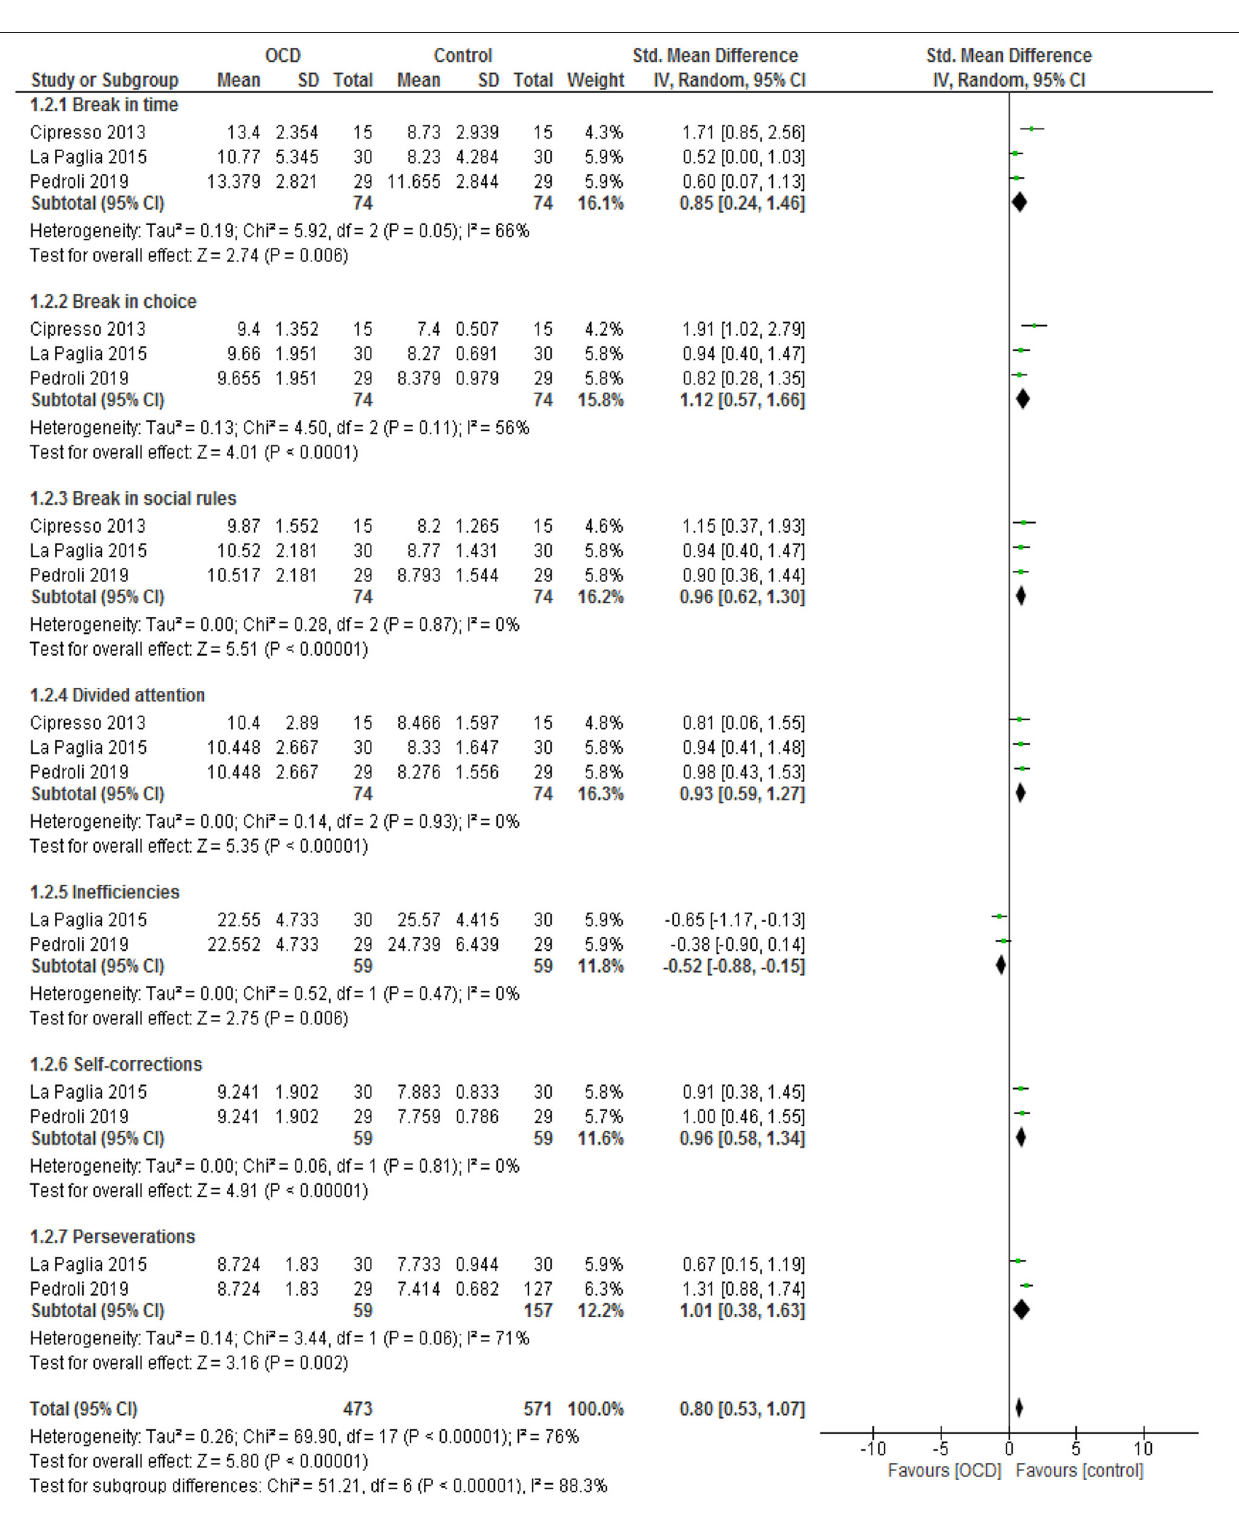
Frontiers in Psychiatry |